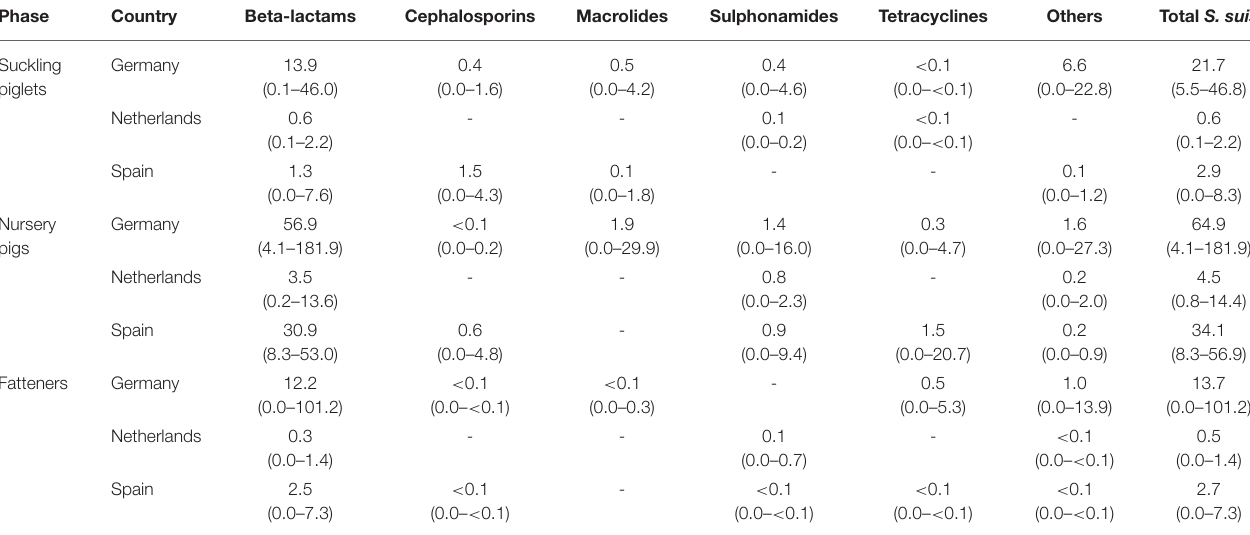
TABLE 3 | The costs of antimicrobials (mean and 90% CI) per animal in affected production units by antimicrobial families for the countries (cost in cents of euros). Phase